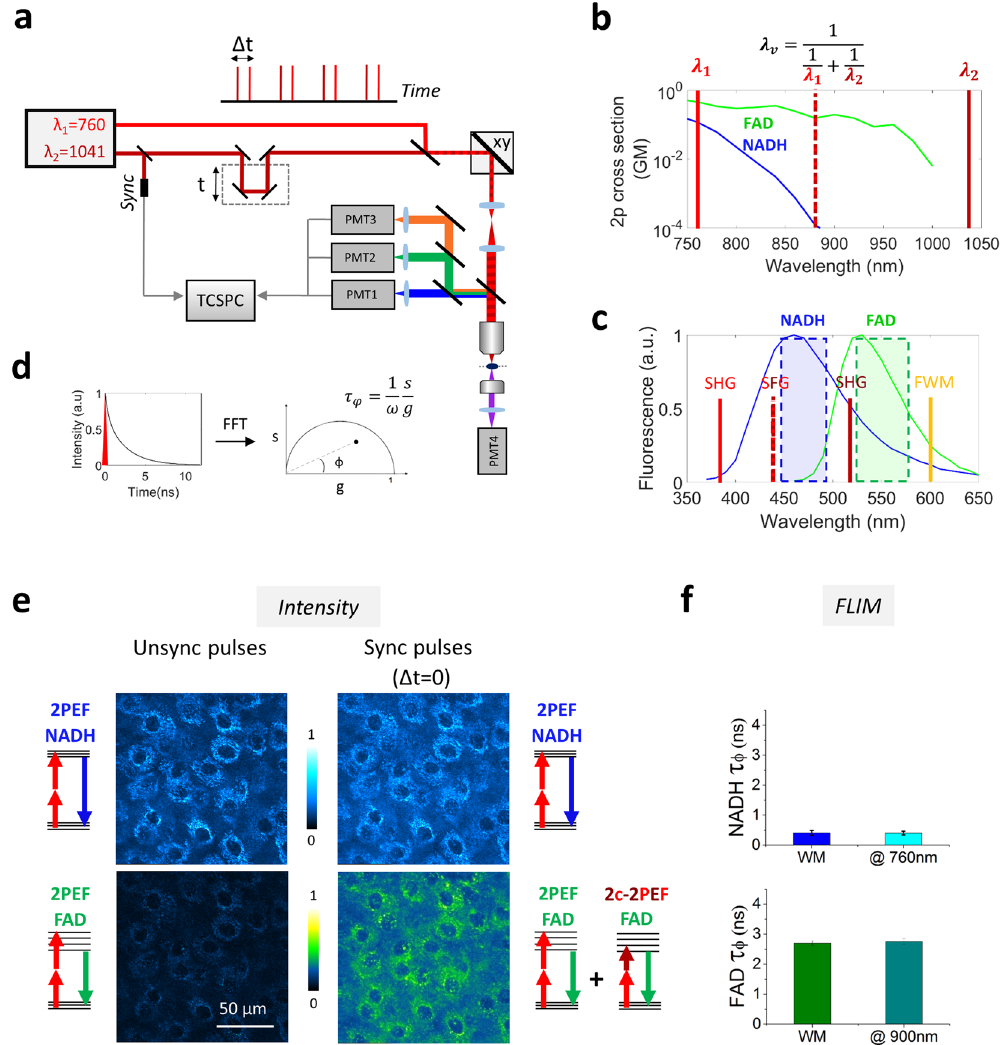
Figure 1. Principle of efficient multicolor two-photon fluorescence lifetime imaging of endogenous fluorophores ( a ) Pulse trains from dual-output femtosecond laser ( λ 1 = 760 nm, λ 2 = 1041 nm) are synchronized using a delay line and co-aligned in the microscope. Pulse synchronization gives rise to two- beam processes such as sum-frequency generation (SFG), two-color two-photon excited fluorescence and four wave mixing (FWM). Fluorescence signals are epi-detected in three different spectral channels, while SHG is forward detected. Time-correlated single photon counting (TCSPC) electronics measures the arrival time of the fluorescence photons with respect to the laser pulse. ( b ) Two-photon cross sections of NADH and FAD. By synchronizing the two beams we create a virtual wavelength for two-photon excitation λ v = 2/(1/ λ 1 + 1/ λ 2 ) that corresponds to 879 nm. ( c ) Emission filters are chosen to select the emission of NADH and FAD and reject coherent signals such as SHG, SFG and FWM. ( d) The multi-exponential fluorescence intensity decay is transformed with a Fourier transform (FFT) and the real (g) and imaginary (s) parts are plotted in the graphical phasor plot. ( e ) Two channels fluorescence images of NADH and FAD in reconstructed human skin using synchronized ( Δ t = 0) and unsynchronized ( Δ t = 1 ps) beams. Two-photon-excited fluorescence (2PEF) for NADH and FAD fluorophores occurs when fluorophores are excited at λ 1 . When the beams are synchronized ( Δ t = 0), FAD fluorescence is enhanced by two-color two-photon excited fluorescence (2c-2PEF). ( f ) Fluorescence lifetime of NADH and FAD is not affected when the fluorophores are two-photon excited by single wavelength or wavelength mixing. Measurements were performed in